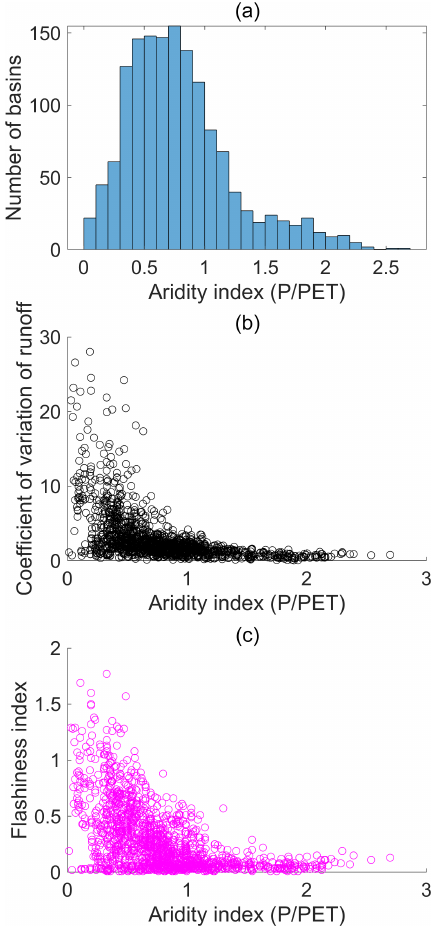
Figure 7. Histogram of the aridity index per basin (a) , relation- ship between the aridity index and the coefficient of variation of runoff (b) , and relationship between the aridity index and the flashi- ness index (c) .